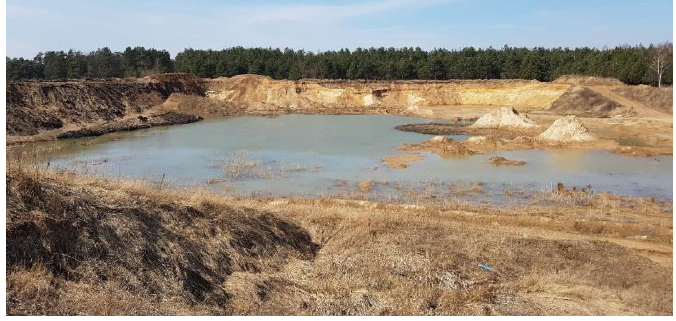
Figure 6. Photograph showing part of the tested excavation.